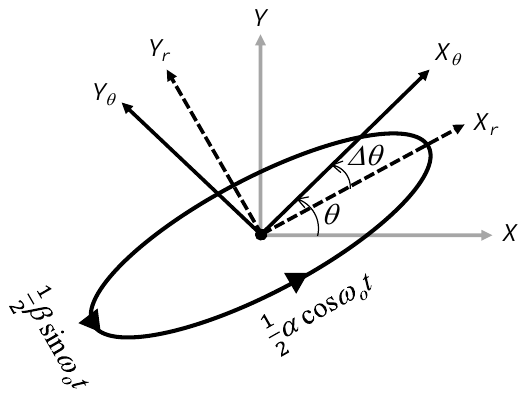
Figure 10. Reference frame of translational motion.